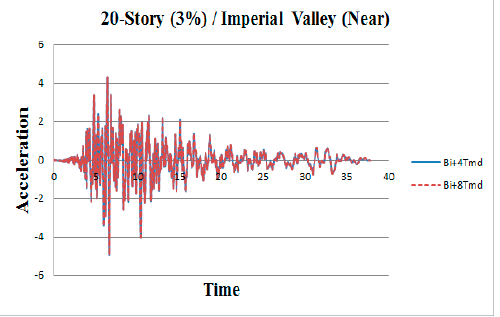
Figure A10. Acceleration time histories for top story of 20-story building under the Imperial Valley (near-fault) earthquake.